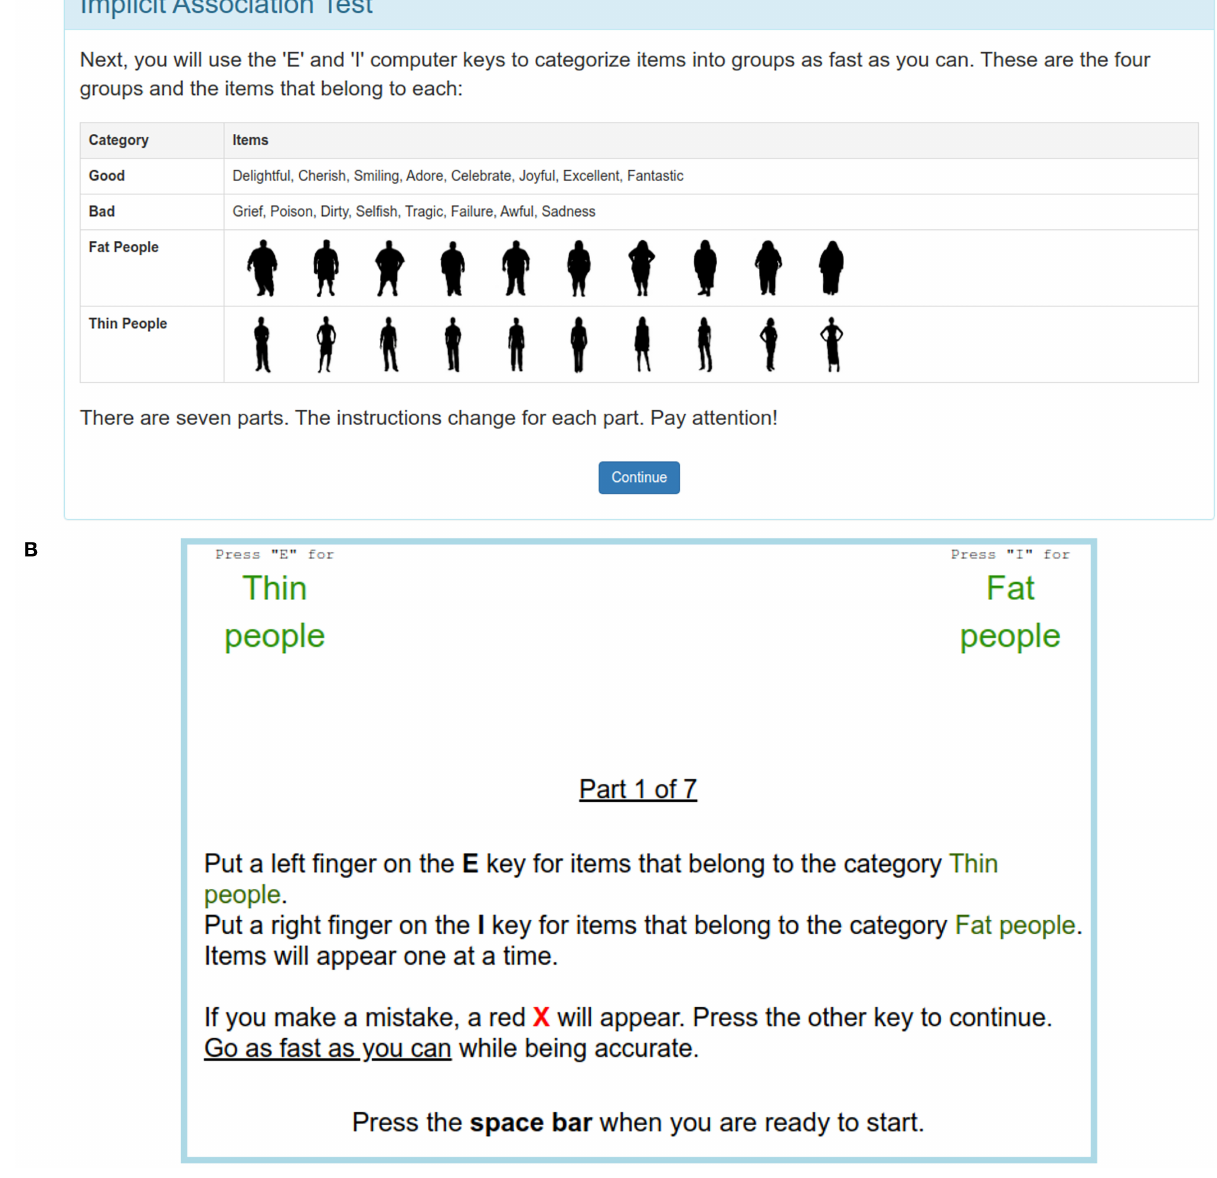
FIGURE 1 | Web-IAT: (A) Introduction for the weight-based IAT (cropped) and (B) first classification task (English language version for illustration purposes).